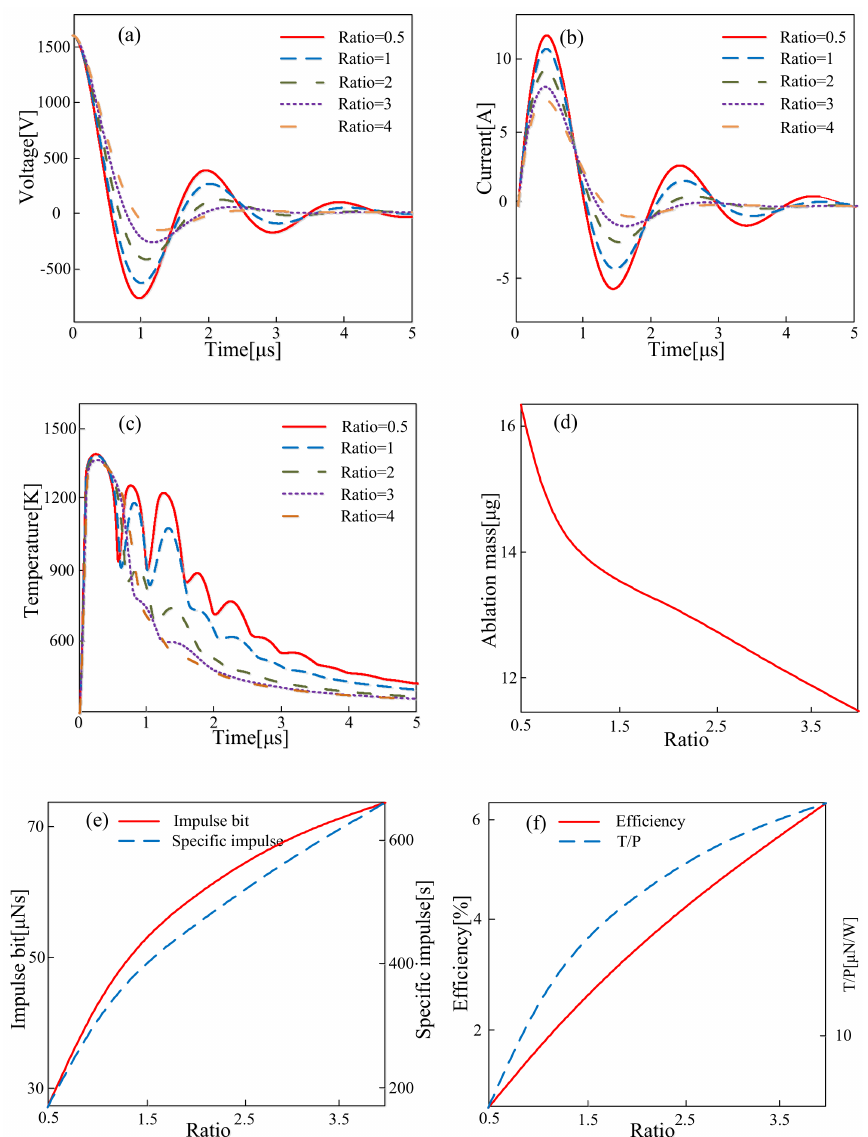
Figure 13. Simulation results at different plate gap-width ratios: ( a ) Discharge voltage waveform; ( b ) discharge current waveform; ( c ) variation of ablation surface temperature with time; ( d ) variation of ablation mass with ratio; ( e ) variation of impulse bit and specific impulse with ratio; ( f ) variation of efficiency and ratio of thrust to power with